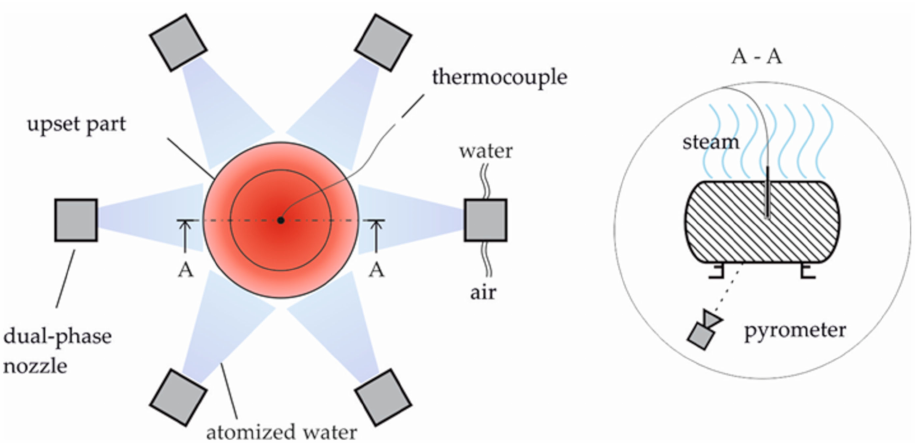
Figure 1. Scheme of the cooling station: top view ( left ) and sectional view ( right ).